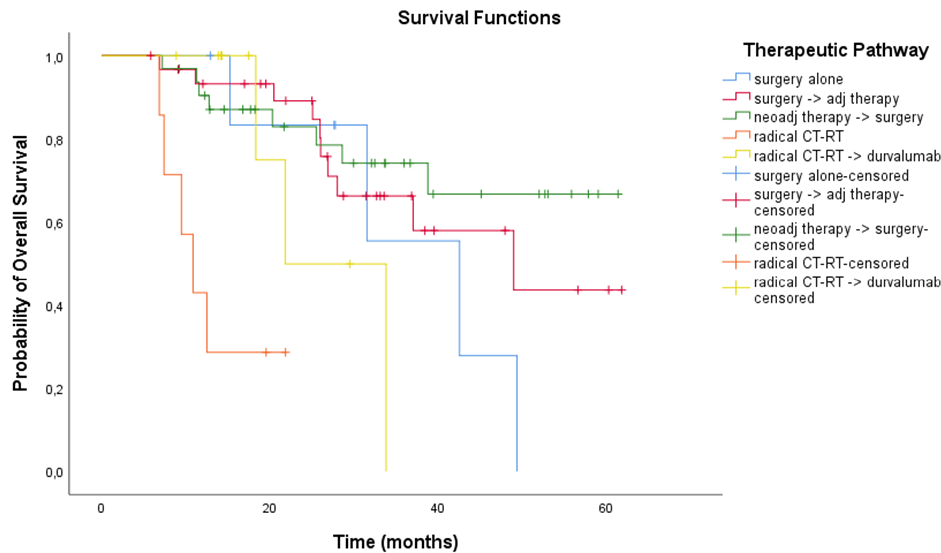
Figure 11. Kaplan–Meier curves of estimated overall survival according to treatment modality in stage IIIA patients treated after 2018. CT-RT, chemo-radiation therapy.